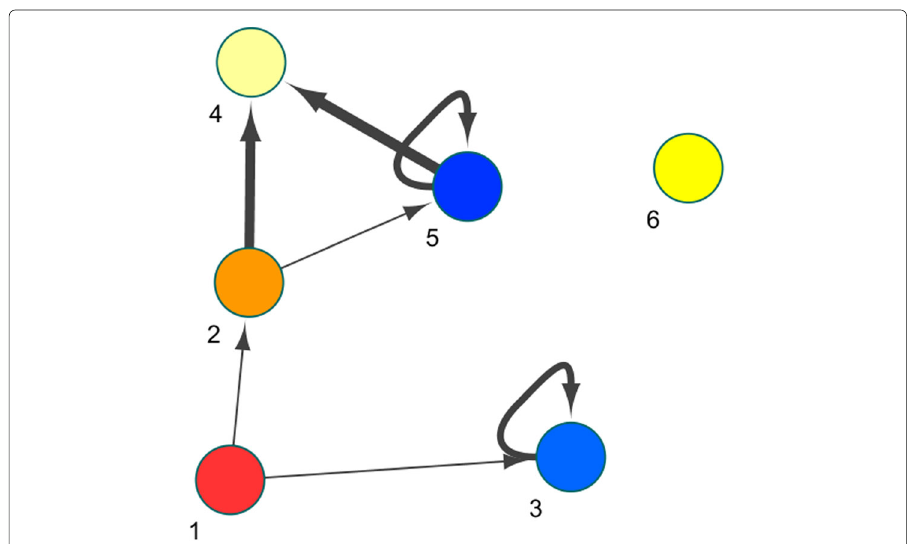
Fig. 7 The reduced diffusion network of node classes for the Schiaparelli case study